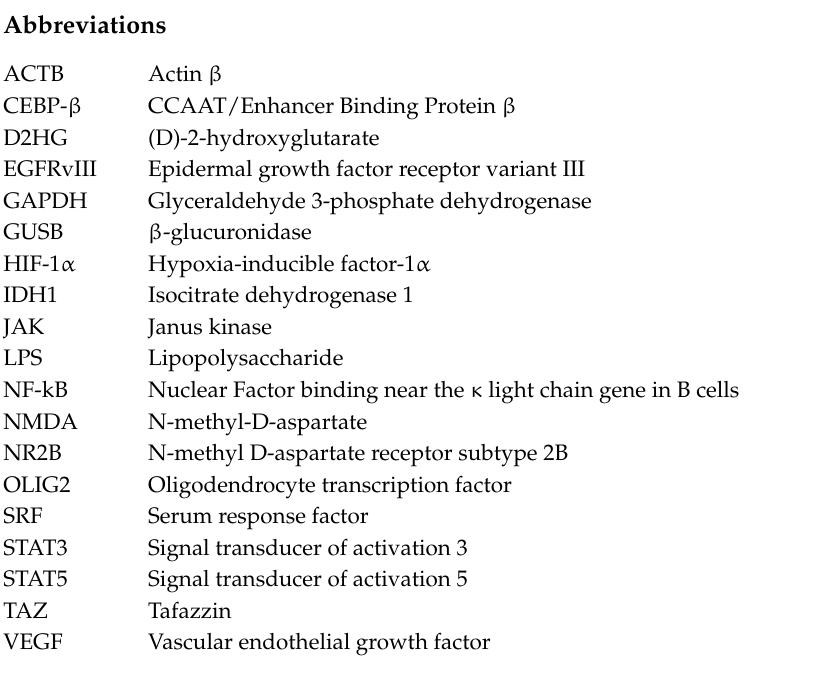
Figure S1: SRF protein expression does not correlate to GBM-associated epilepsy, Table S1: Baseline table fresh-frozen tissues, Table S2: Baseline table TMA cohort, Table S3: GSEA results MSigDB C2